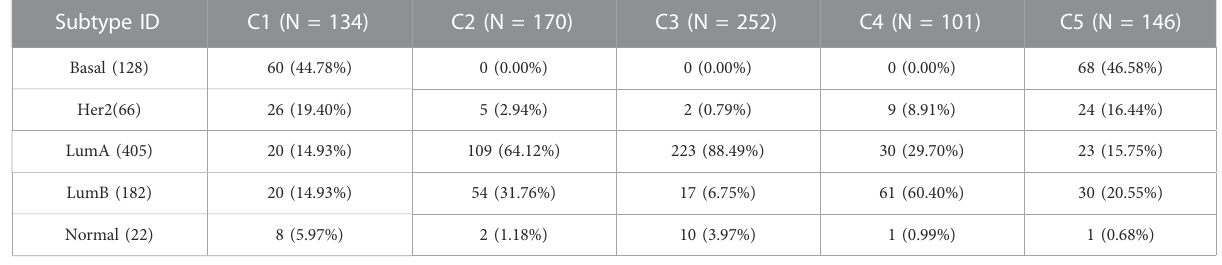
TABLE 8 The overlaps of the identi fi ed subtype clusters with PAM50 subtypes in BRCA cancer datasets.